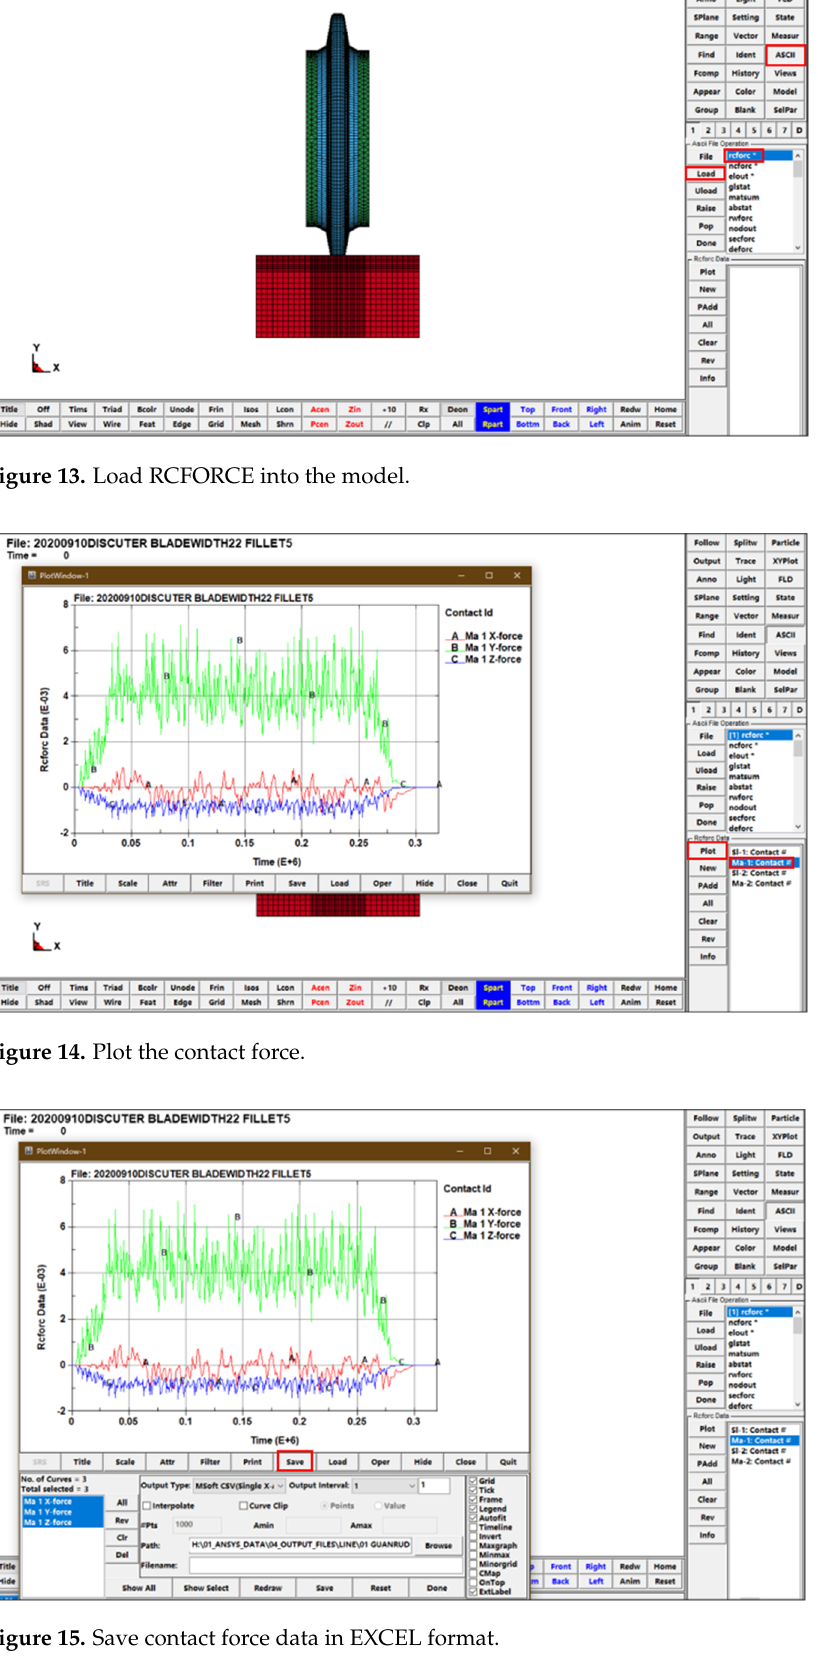
Figure 15. Save contact force data in EXCEL format.